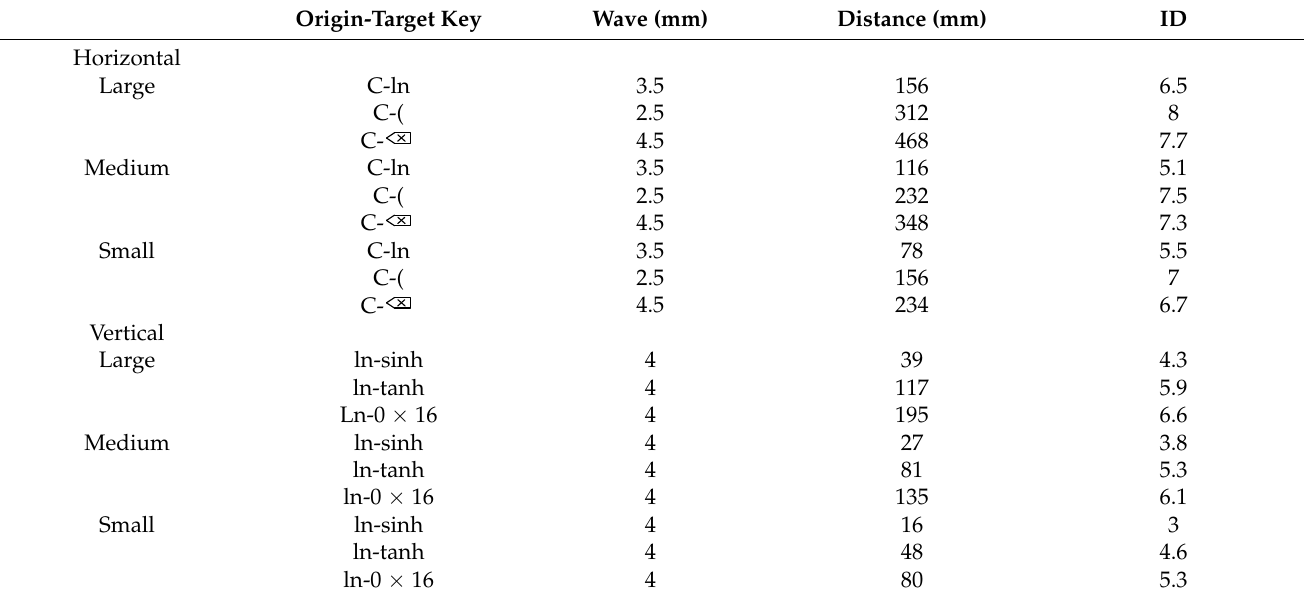
” were the 3rd, 5th, and 7th keys for horizontal pointing; “sinh”, “tanh”, and “0 × 16” were the 2nd, 4th, and 6th keys for vertical